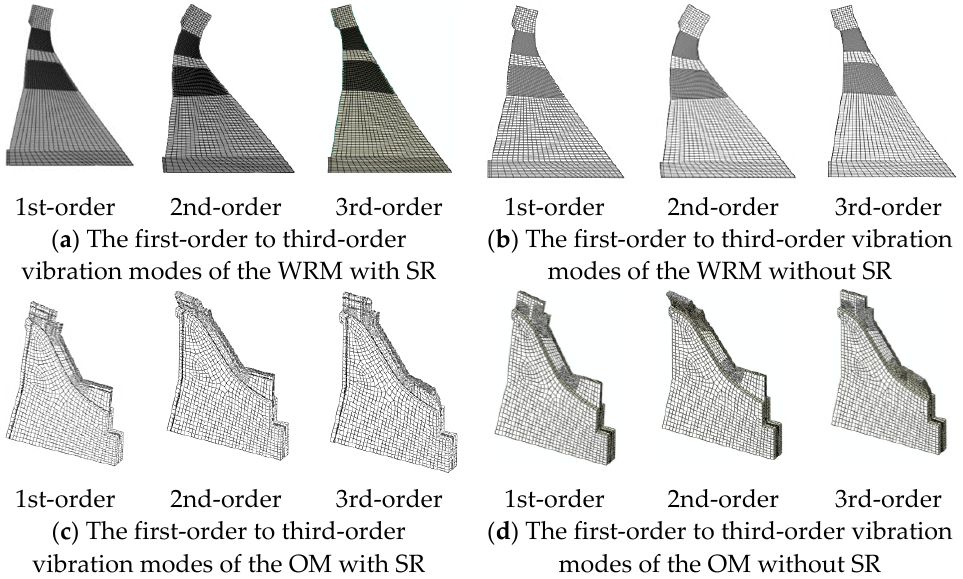
Figure 12. The vibration modes of the prototype numerical model.